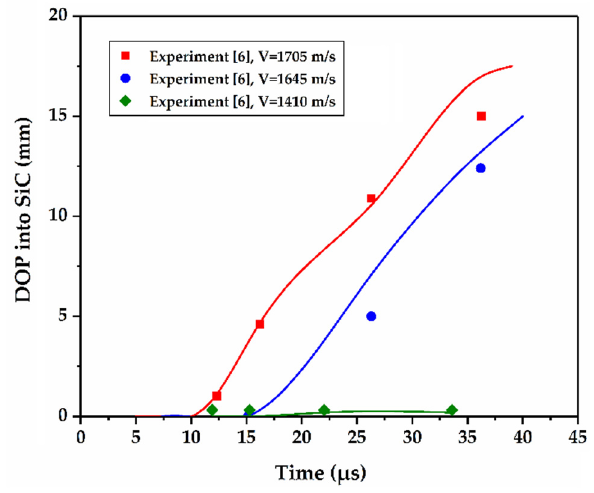
Figure 4. Comparison of depth of penetration (DOP) results obtained from simulations with experimental measurements [6].